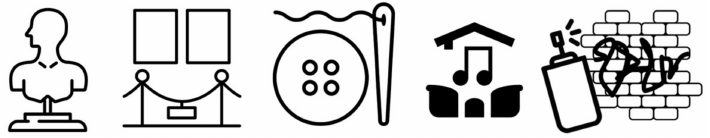
Figure 2. Icons visually representing the Art Seeker